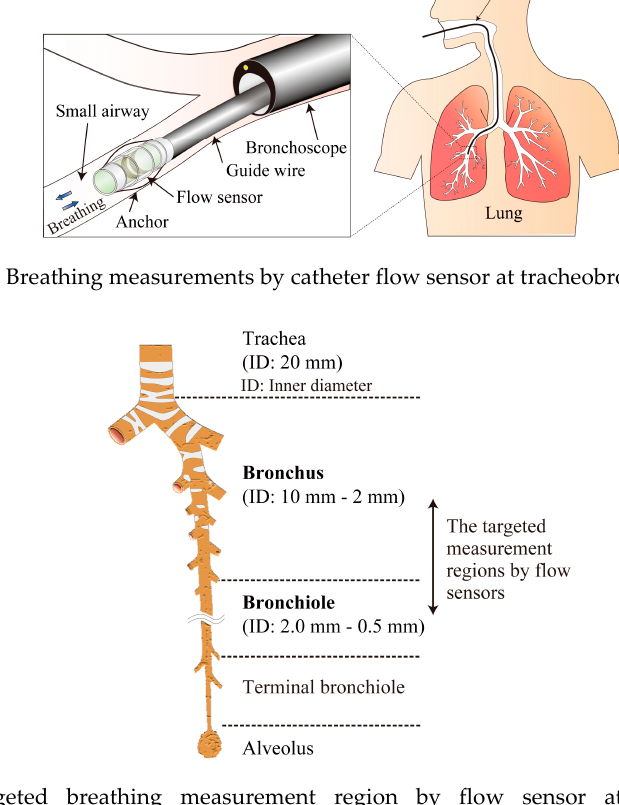
Figure 2. Targeted breathing measurement region by flow sensor at different levels of tracheobronchial